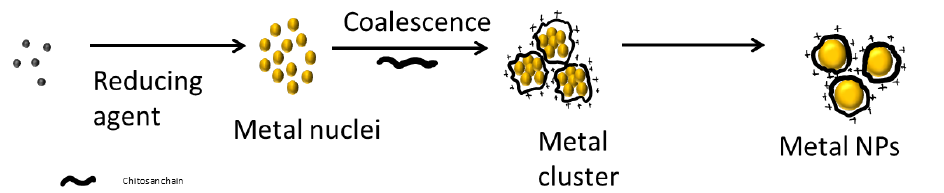
Figure 4. Scheme of metallic nanoparticle production and stabilization with chitosan.